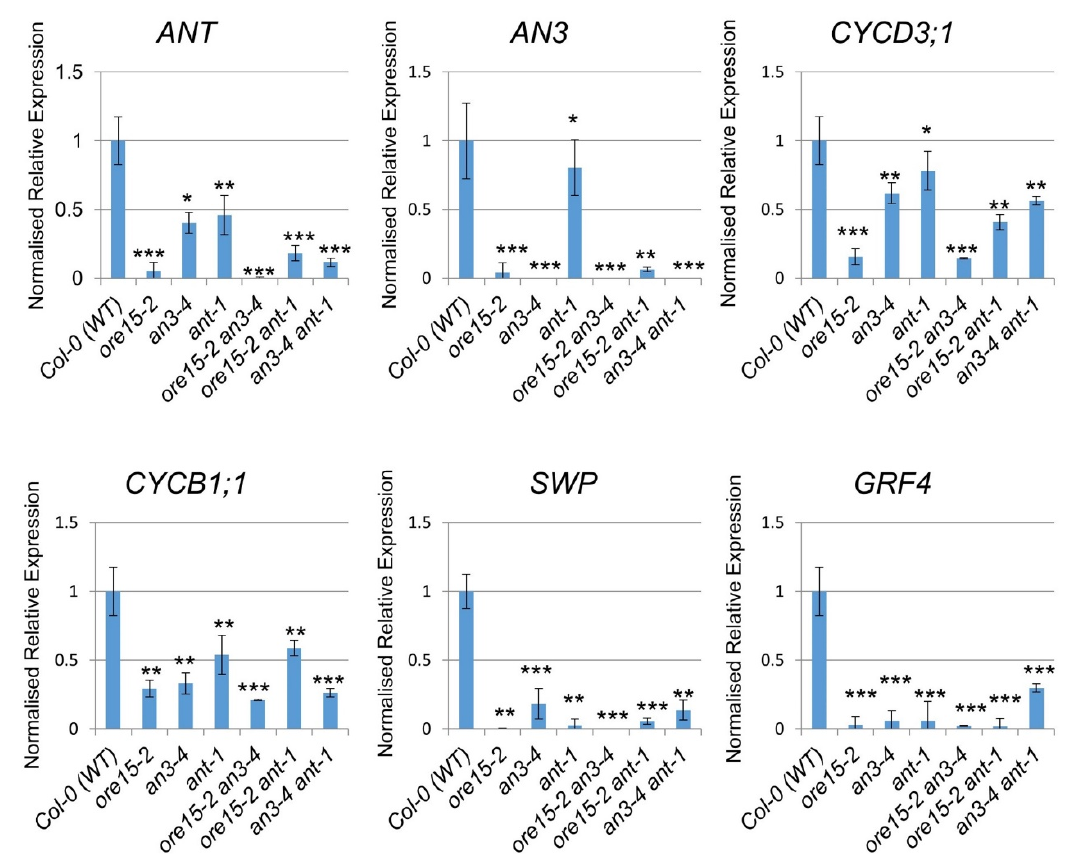
Figure 5. Expression of cell proliferation-related genes in the blades of cell proliferating leaves (third to fifth leaves) of Col-0 (WT), single mutant, and double mutant plants at 13 DAS. The transcript abundance of each gene was analyzed by quantitative reverse transcription polymerase chain reaction (qRT-PCR) using primers specific to each gene, normalized to TUB4 , and are shown as values relative to each level of the Col-0 (WT). Data are representative of three technical replicates. Plotted values are means ± SE ( n = 3). A statistical analysis was performed using a one-way ANOVA. Asterisks indicate significant difference from Col-0 (WT) plants (*, p < 0.1; **, p < 0.05; ***, p < 0.01).